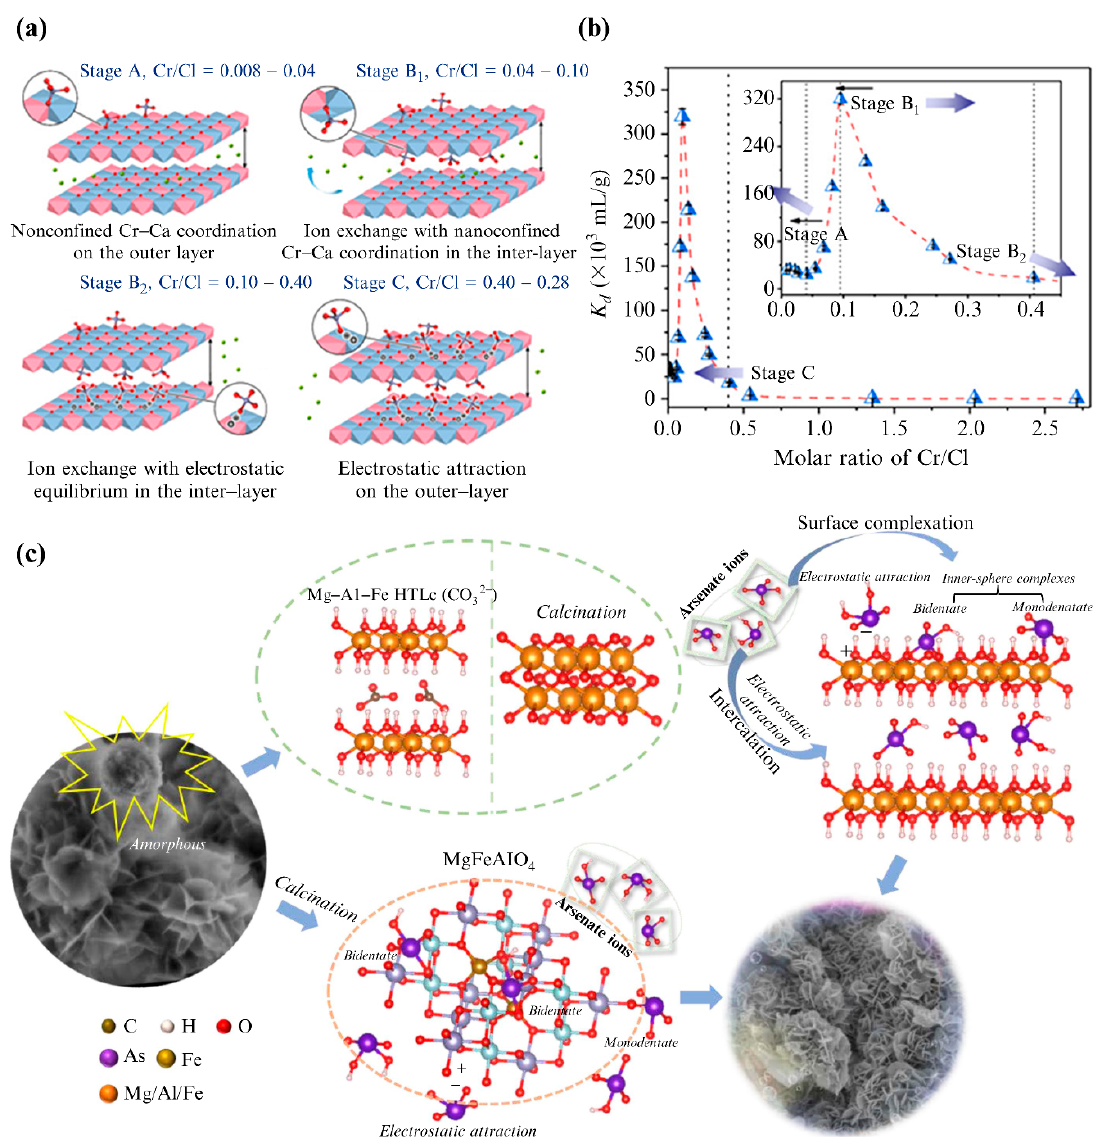
Figure 5. ( a ) Schematic of the binding force transformation between Cr(VI) and hydrocalumite with different Cr(VI) loadings. ( b ) Plot for the k d values versus Cr/Cl ratios. Reproduced with permission from [40]. Copyright {2021} American Chemical Society. ( c ) Proposed As(V) removal mechanism by calcined Mg–Al–Fe LDH. Reproduced with permission from [41].